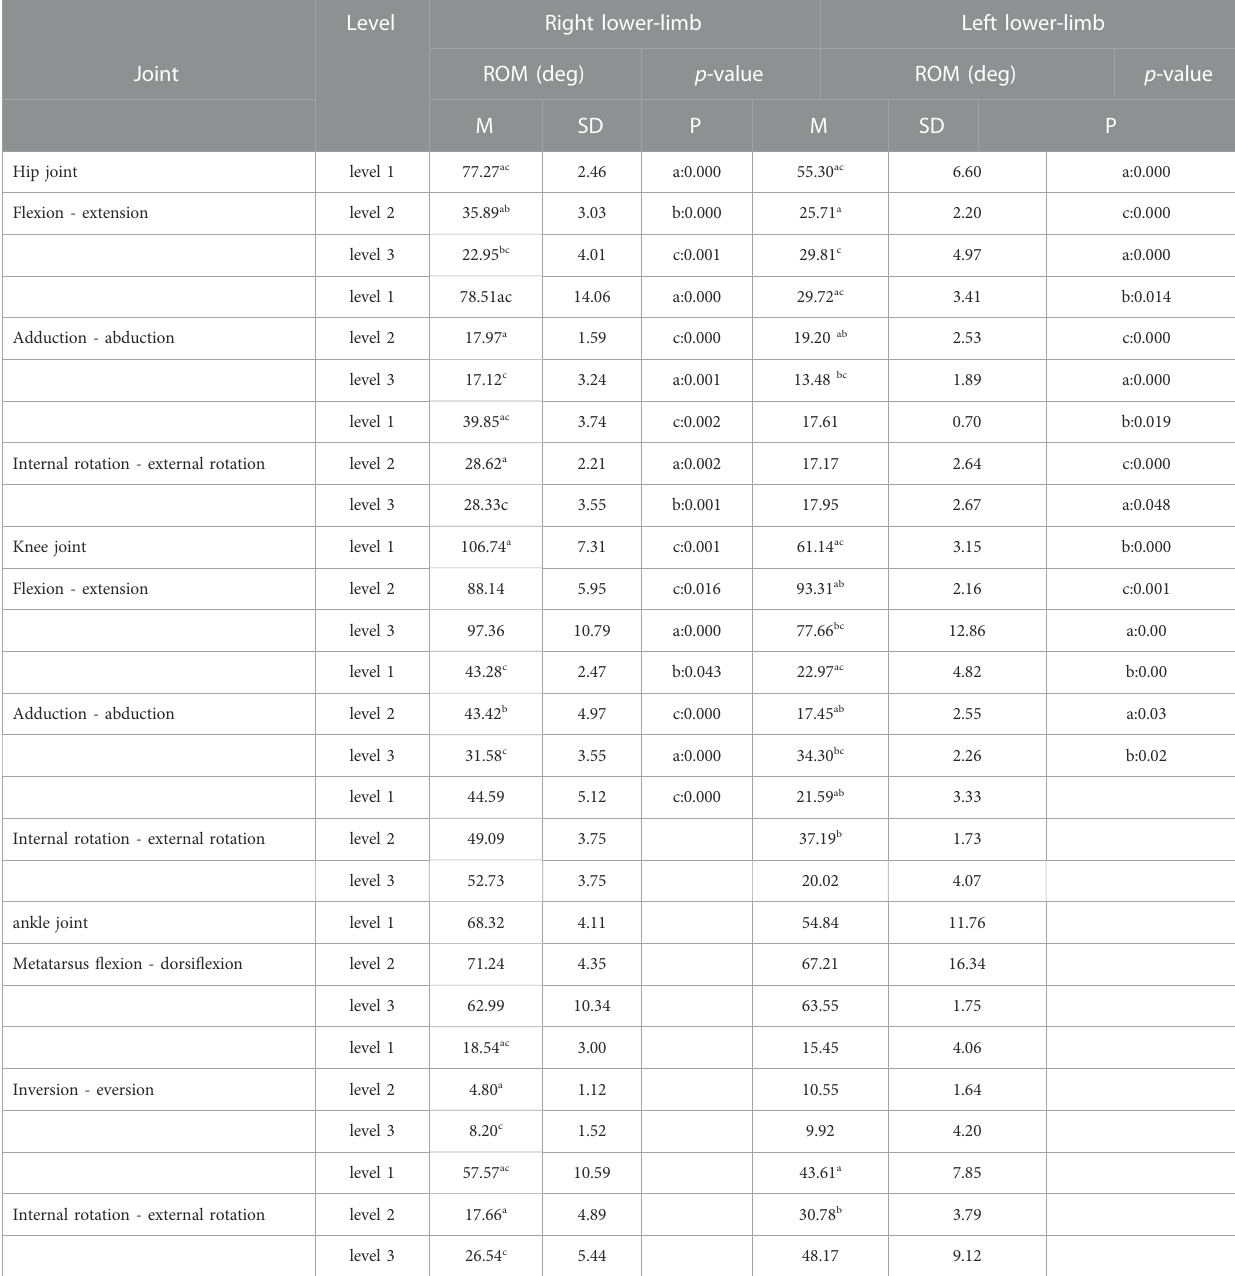
TABLE 1 Bilateral lower-limb joint ROM of level 1, level 2, and level 3 during the takeoff phase. Level Right lower-limb Left lower-limb Joint ROM (deg) p -value ROM